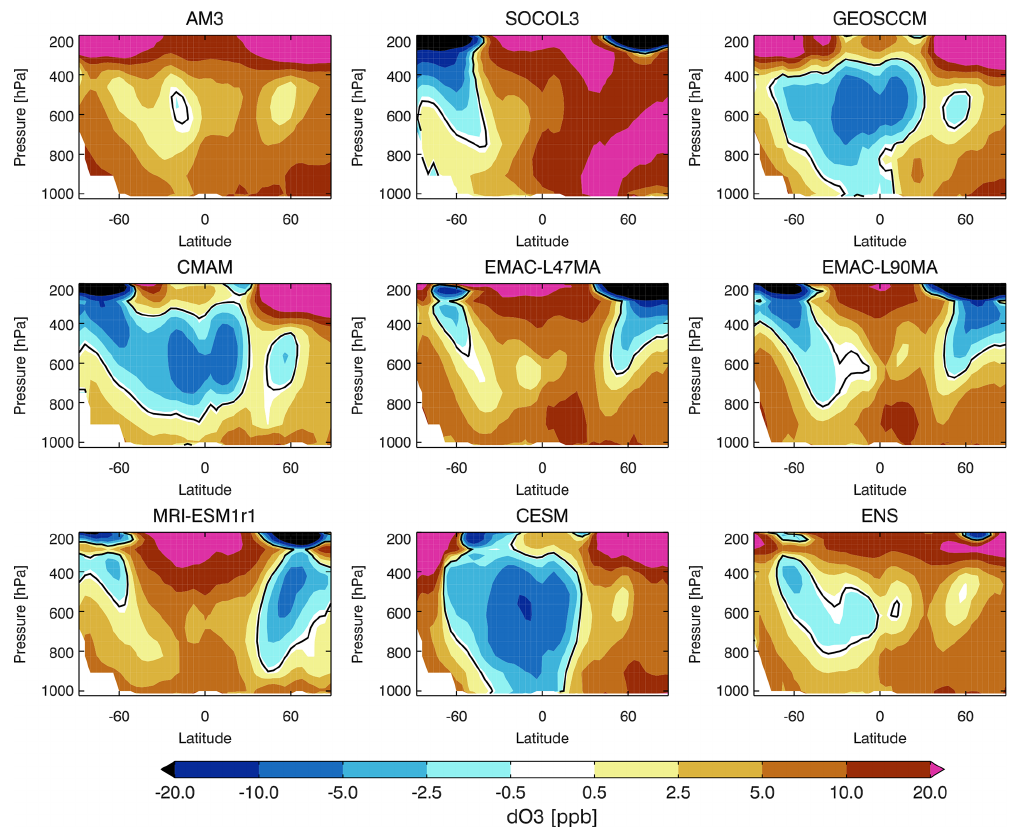
Figure 9. The zonal averaged vertical–latitudinal distribution of O 3 model biases to the TCR-1 O 3 assimilation data. The black curves are the zero